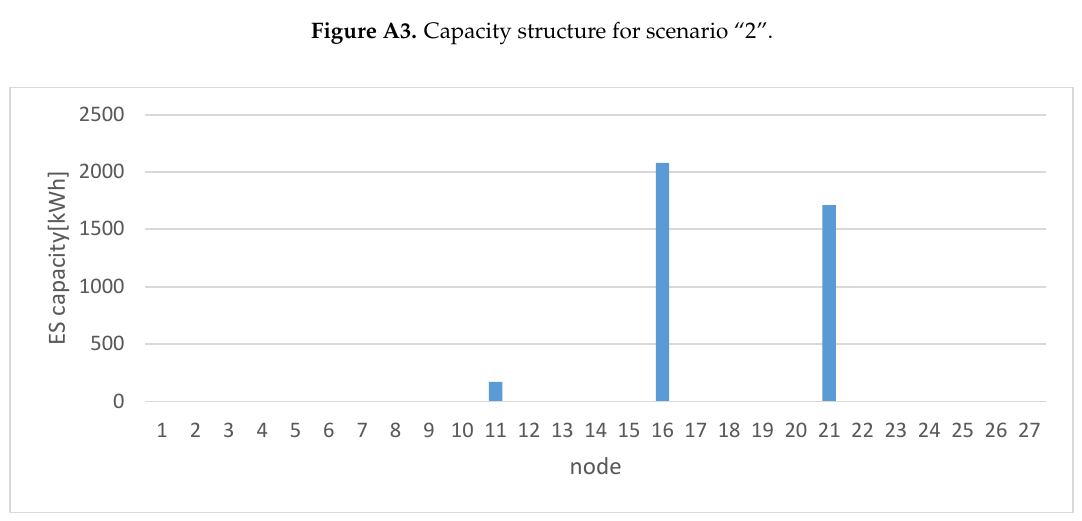
Figure A4. ES capacity structure for scenario “2”.